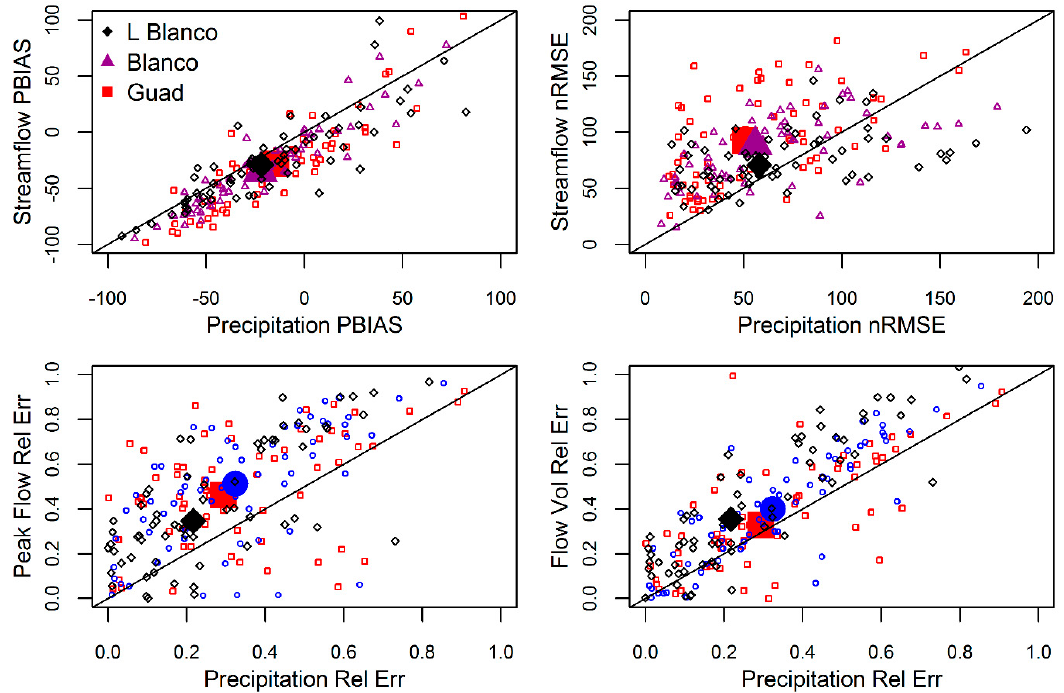
Figure 9. Annual Error propagations descriptions comparing streamflow and precipitation percent bias (PBIAS) and normalized root-mean-square-error (nRMSE) ( top left and top right , respectively) and relative error in precipitation versus peak flow relative error ( bottom left ) and streamflow volume relative error ( bottom right ) N.B. the big markers represent the mean value.